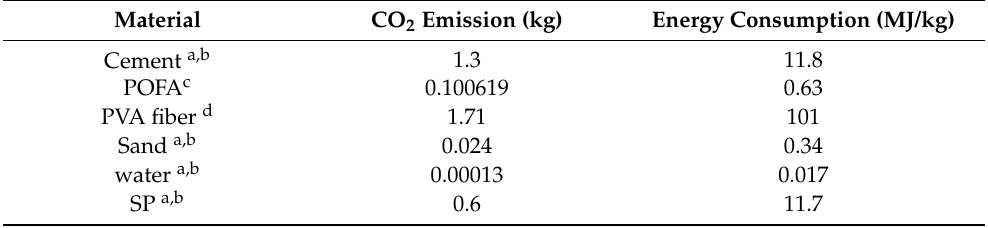
Table 3. CO 2 emissions and energy consumption per 1 kg of raw